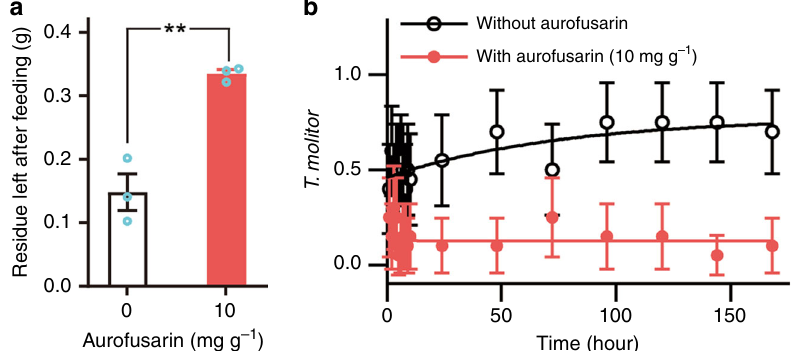
Fig. 4 Aurofusarin in wheat fl our repels mealworms. a The weight of the wheat fl our and faeces left by fi ve larvae of T. molitor after 4 d of feeding on 0.4 g of wheat fl our with and without 10 mg g − 1 of aurofusarin. The signi fi cance of the difference was analysed with unpaired two-tailed t test ( n = 3, p = 0.0033). b Single mealworms were placed on Petri dishes between two portions of 100 mg of wheat fl our, one of which was amended with 10 mg g − 1 of aurofusarin. The arenas were kept in total darkness and opened only for a second in dim light to record the mealworm location ( n = 20, error bars show CI 95%). Source data are provided in a Source Data fi le